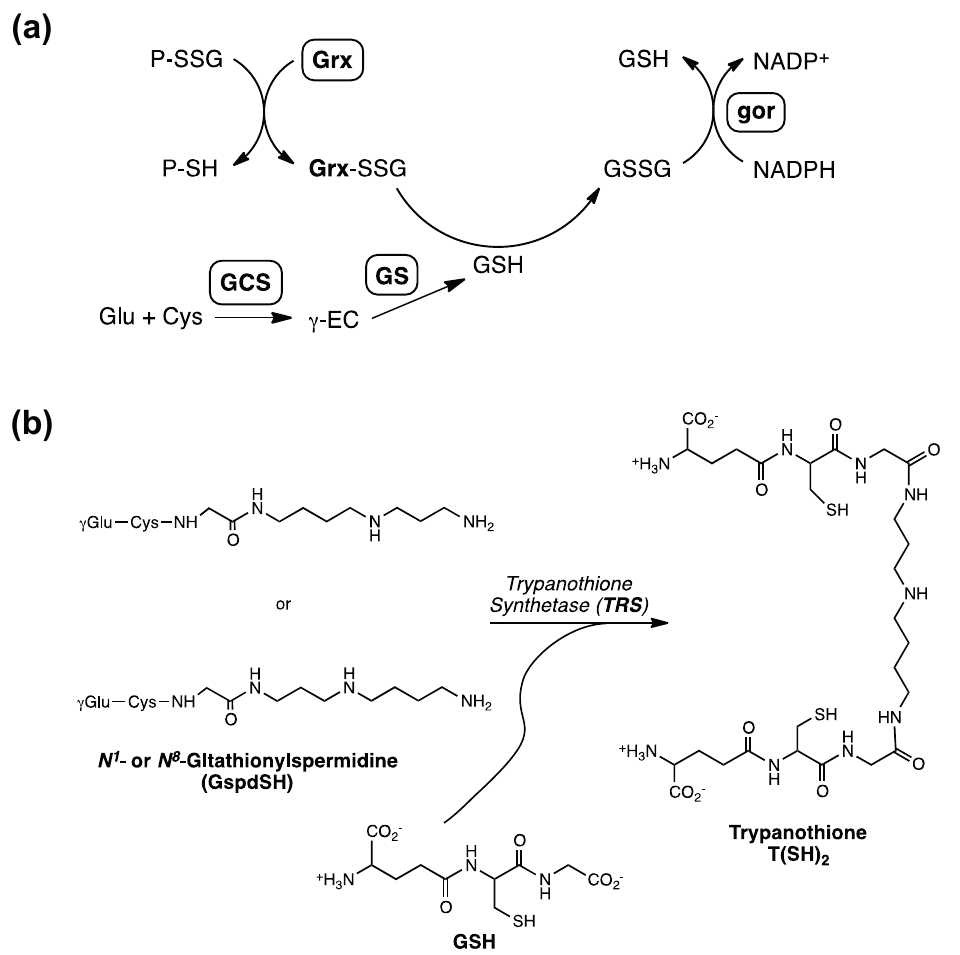
Figure 1. ( a ) Metabolic pathway of glutathione (GSH) involving γ -glutamylcysteine synthetase (GCS), glutathione synthetase (GS) as well as the enzymatic cycling of GSH reductase (gor) and glutaredoxin (Grx) to facilitate the conversion of GSH to GSSG. Reduction of P-SSG by Grx leads to a Grx-SSG intermediate that is further reduced by GSH to produce GSSG, which is reduced by gor ( γ EC: γ -glutamylcysteine). ( b ) The